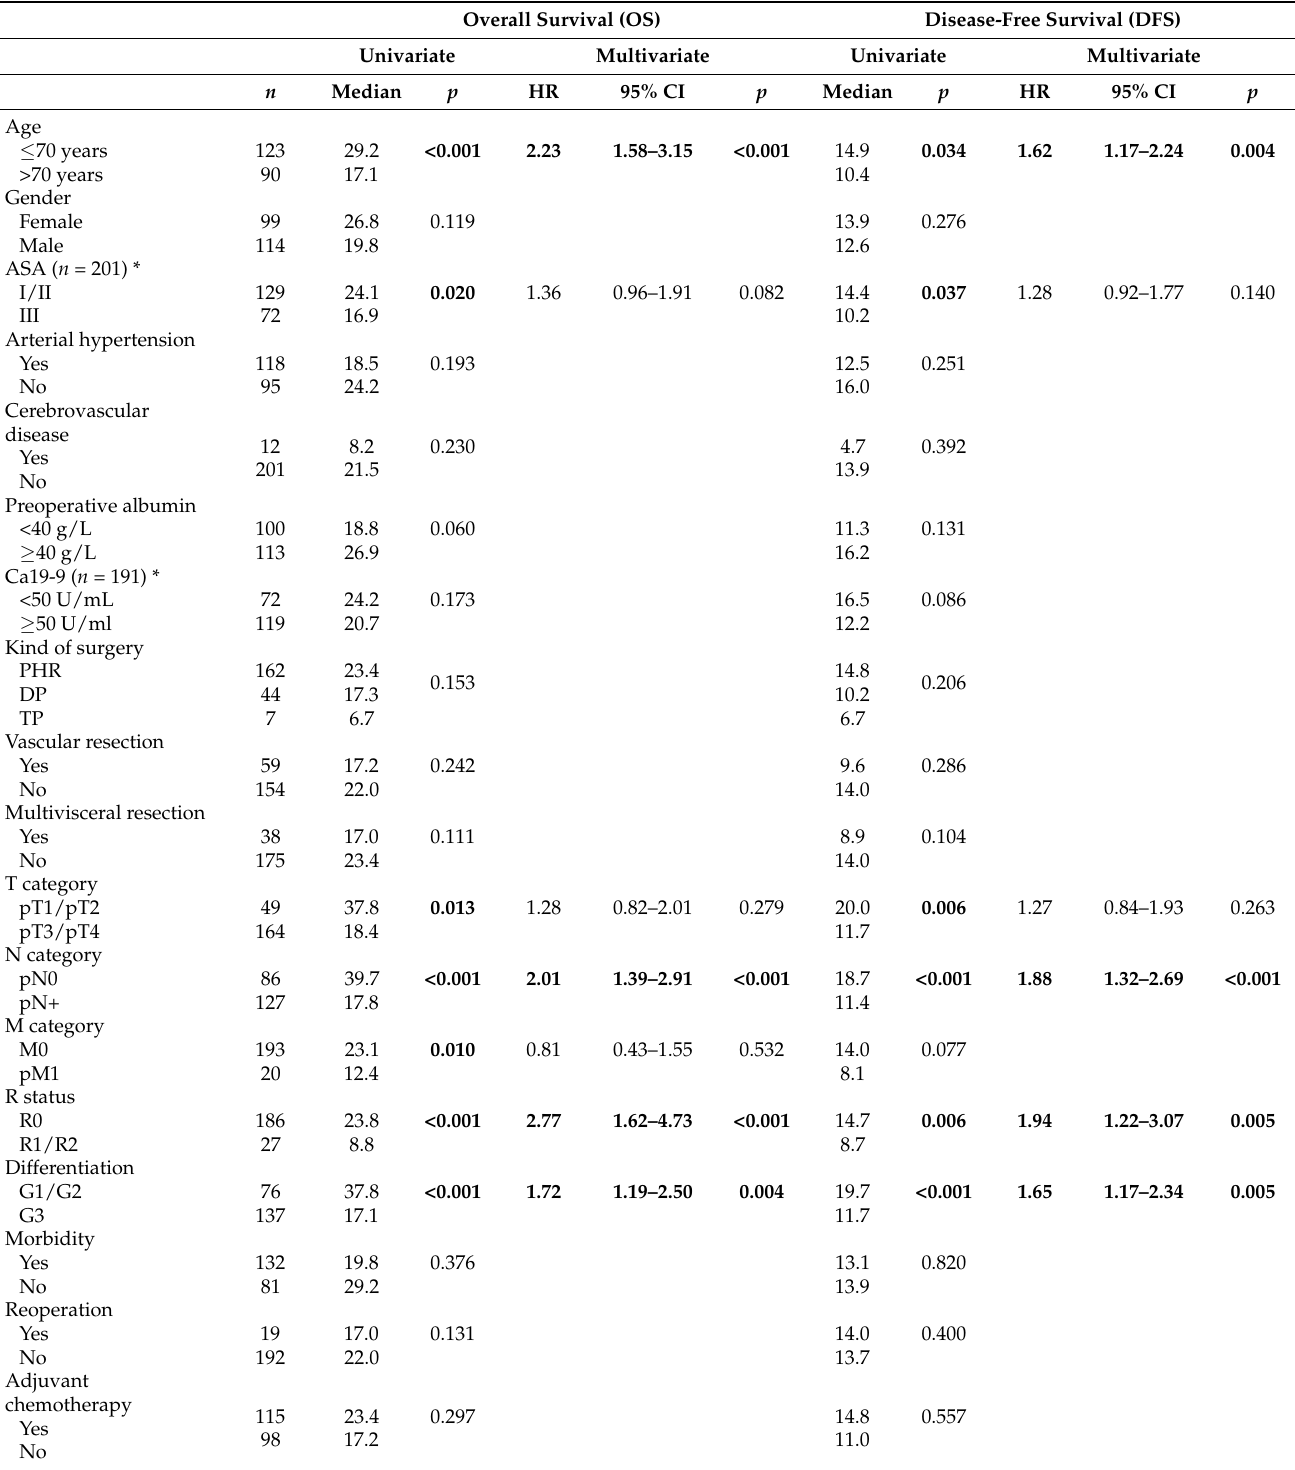
Table 4. Prognostic factors of patients with resected pancreatic ductal adenocarcinoma for overall survival (OS) and disease-free survival (DFS). Overall Survival (OS) Disease-Free Survival (DFS) Univariate Multivariate Univariate